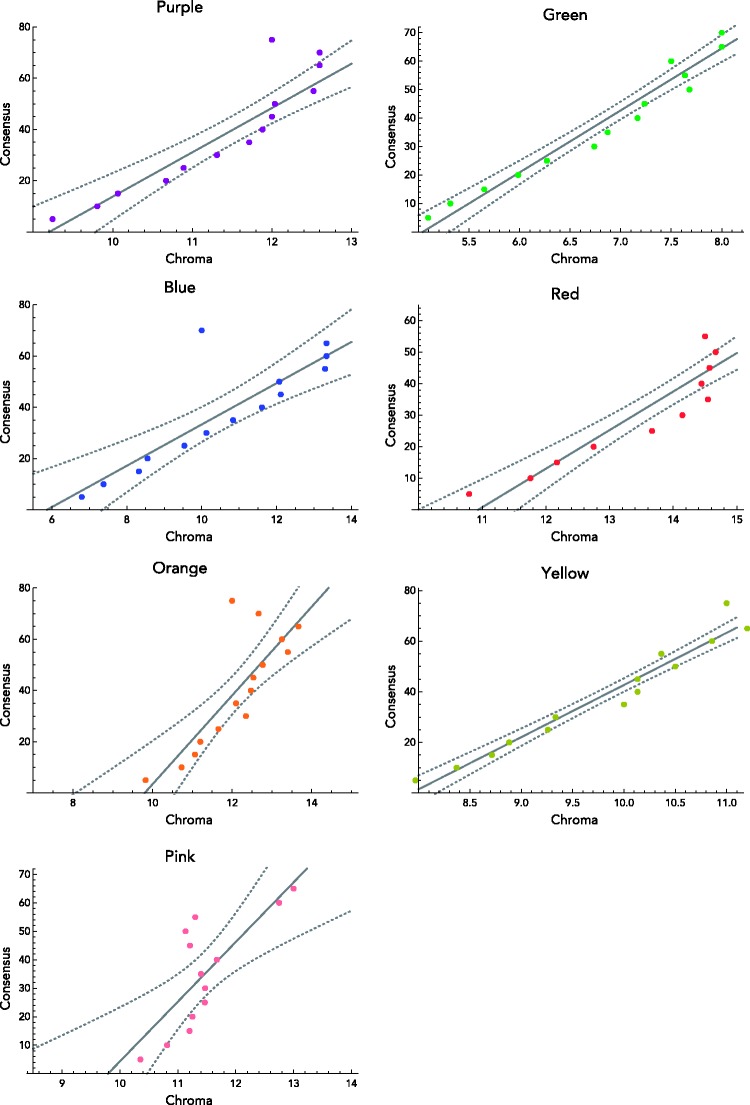
Plots of linear models with chroma as positive predictor of consensus. Dotted lines indicate 95% confidence bands.